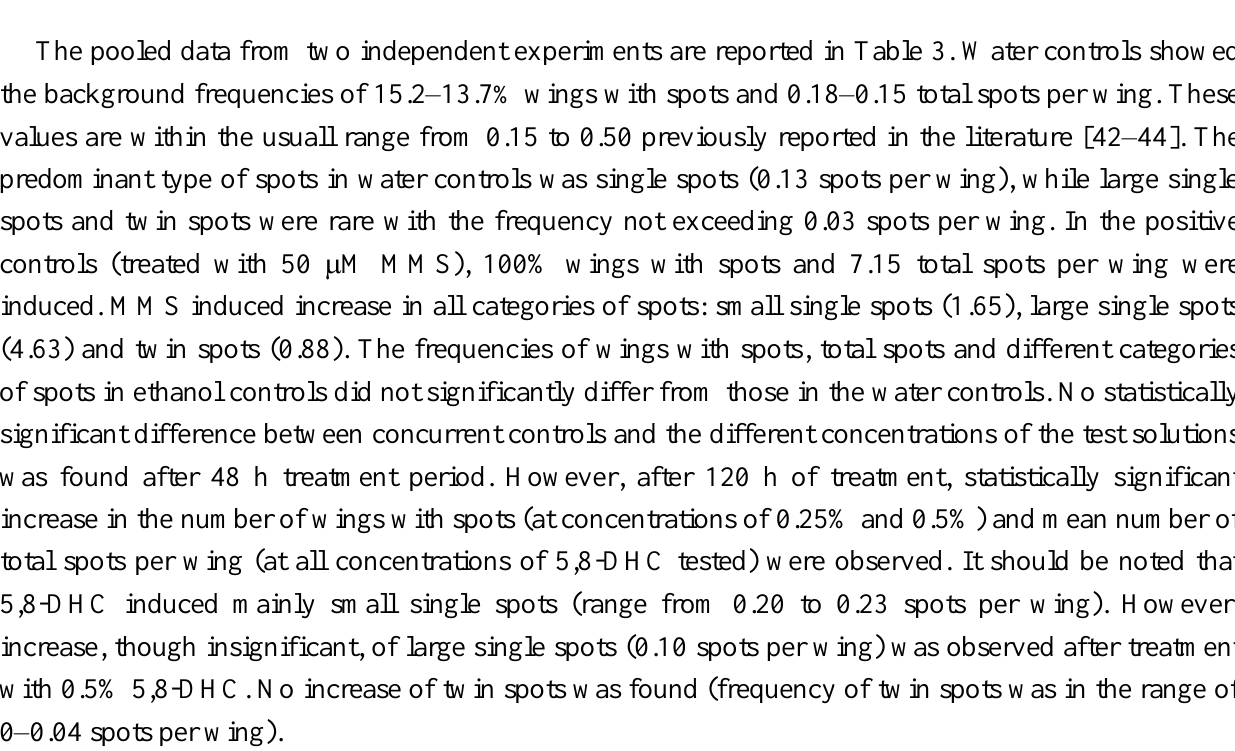
Table 3. Summary of results in the Drosophila wing spot test after the treatment